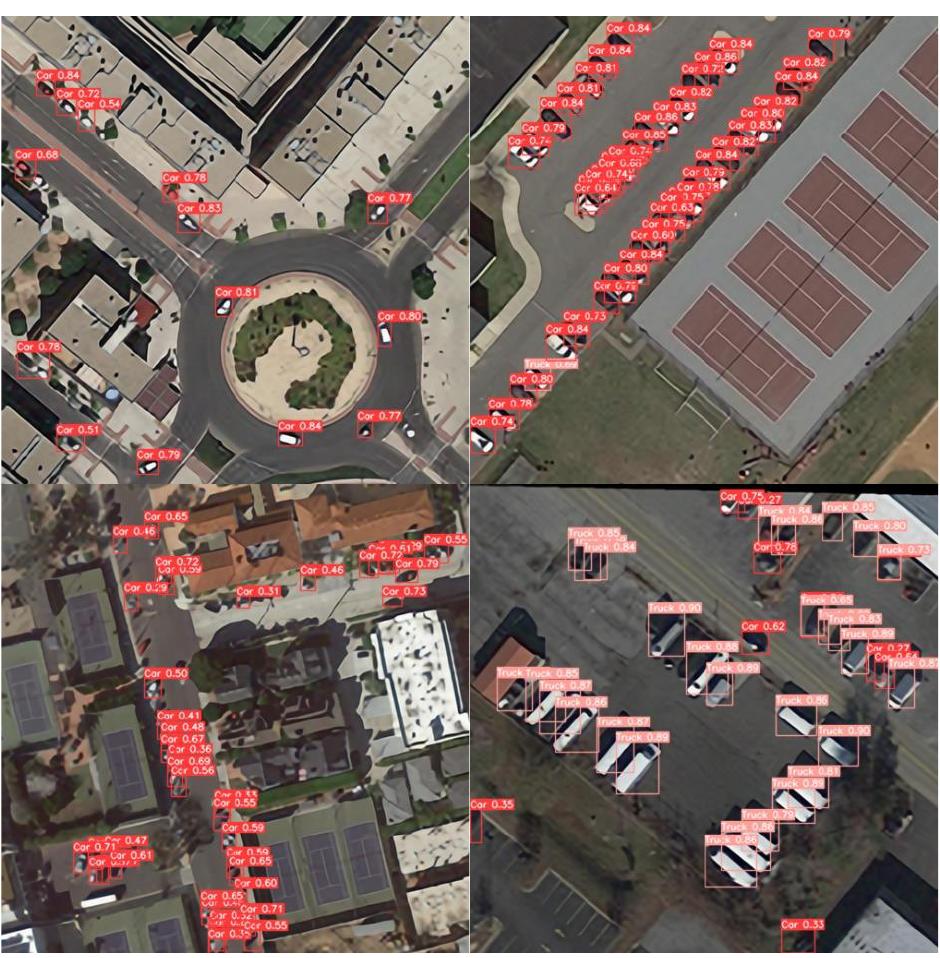
Figure 8. Various object detection results on aerial images of the DOTA dataset.